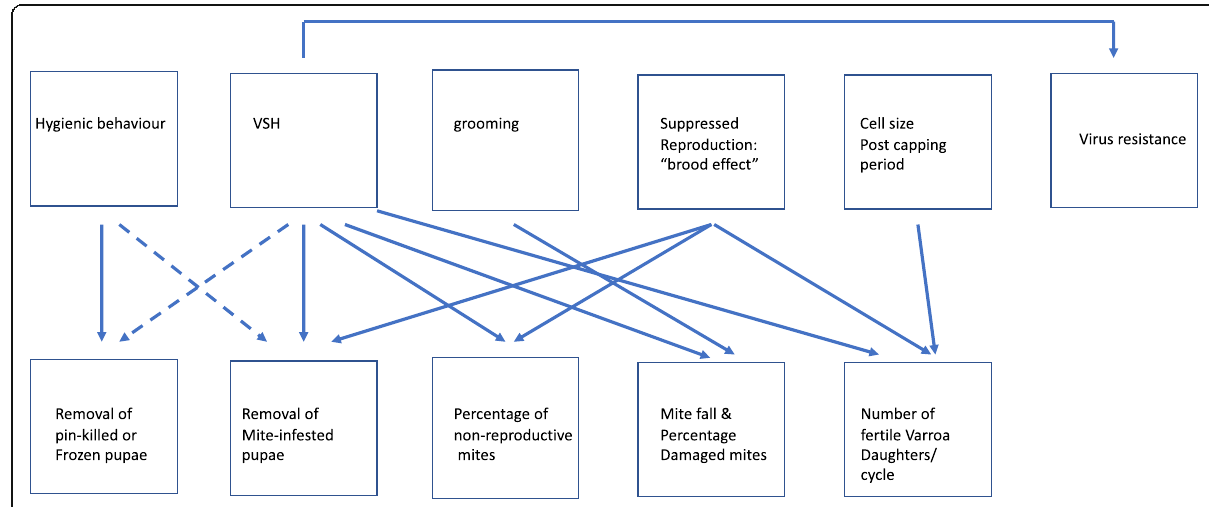
Fig. 1 Relationships among honeybee resistance traits and data collected to measure them. Arrows explained in the